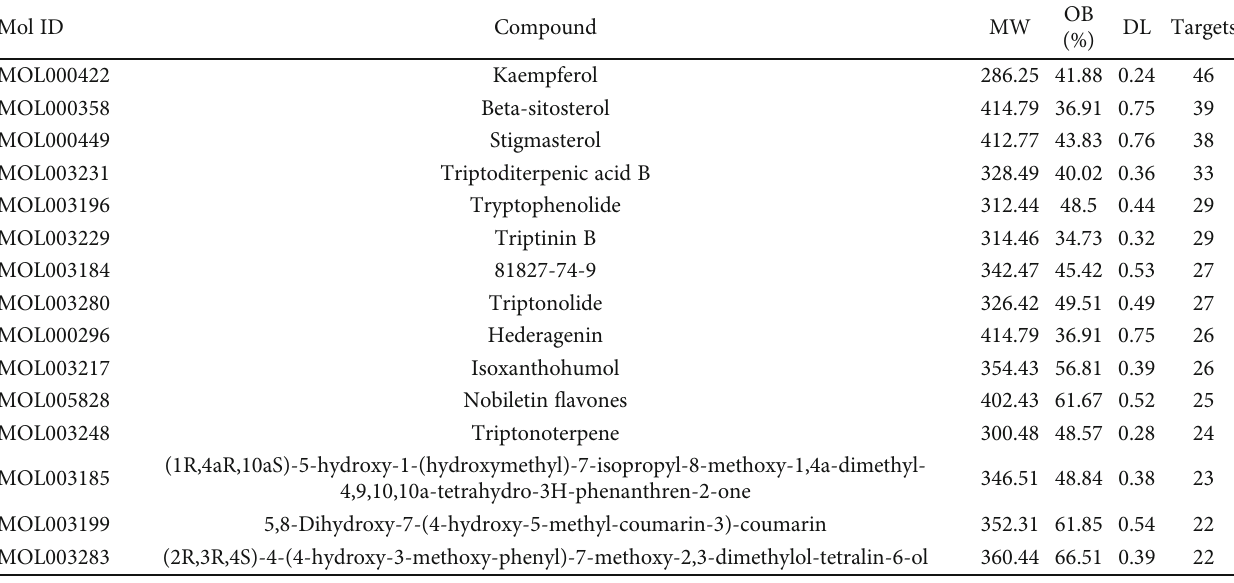
Table 1: Basic information of active components in TwHF.